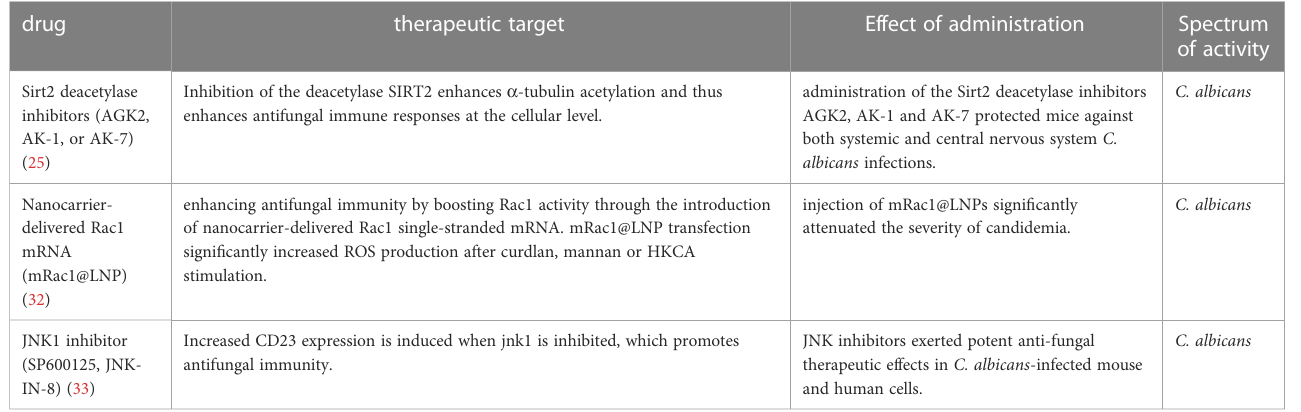
TABLE 2 Antifungal drugs discovered in the last 5 years.